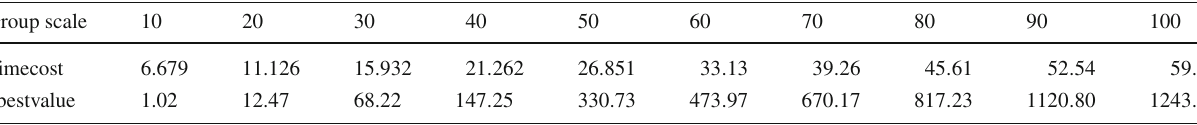
Table 13 Time cost for different scale of UAV group by AHPSODE Group